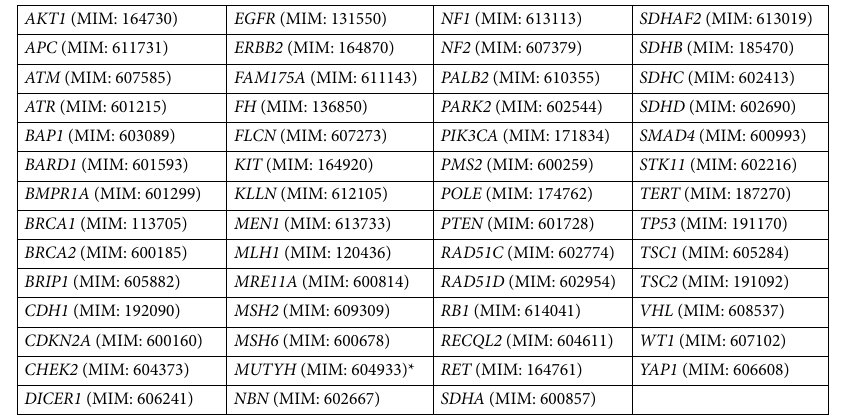
Table 1. Gene list used for analysis (n = 55). *Considered to be associated with tumor predisposition in the homozygous or compound-heterozygous